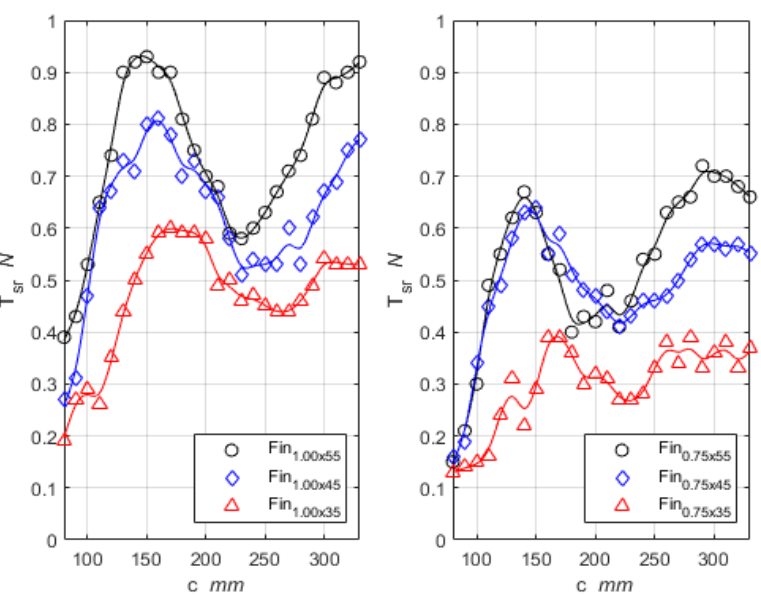
Figure 8. Thrust mean ( T sr ) as a function of the fins length for different fin widths and thicknesses.